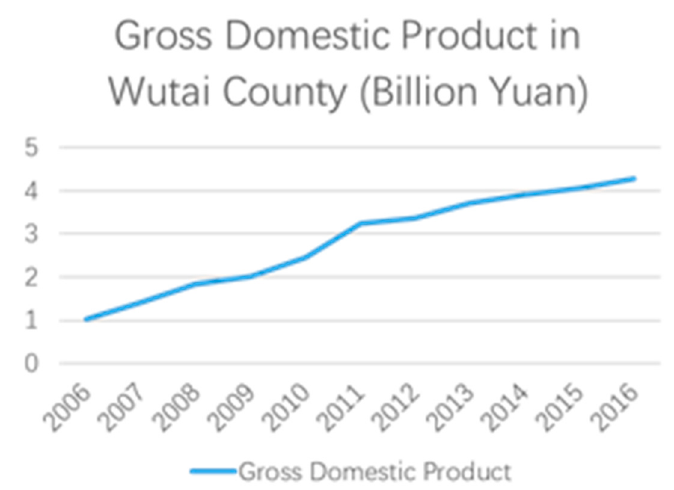
Figure 12. Coal primary product.